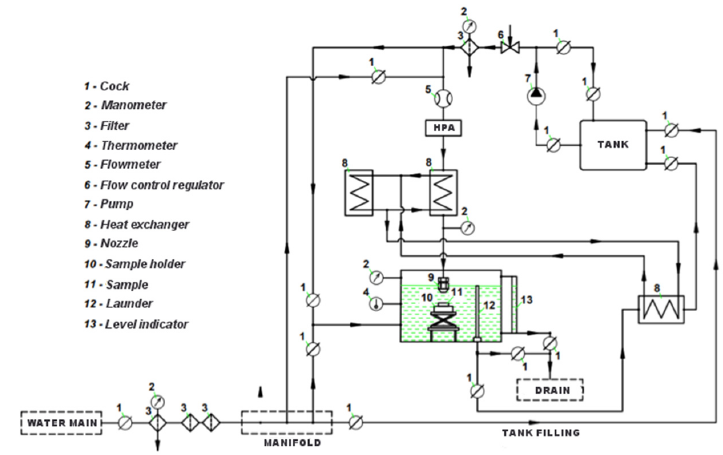
Figure 1. Diagram of prototype cavitation jet test rig.